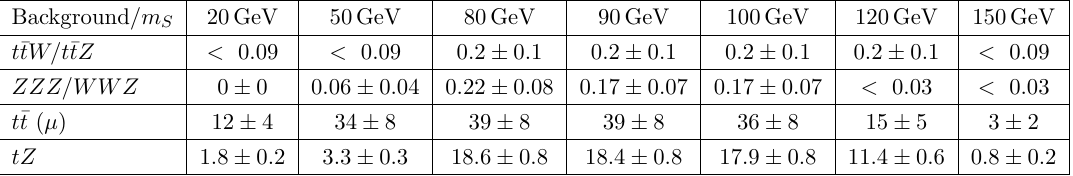
Table 4 . Event yields for the last selection cut on m rec